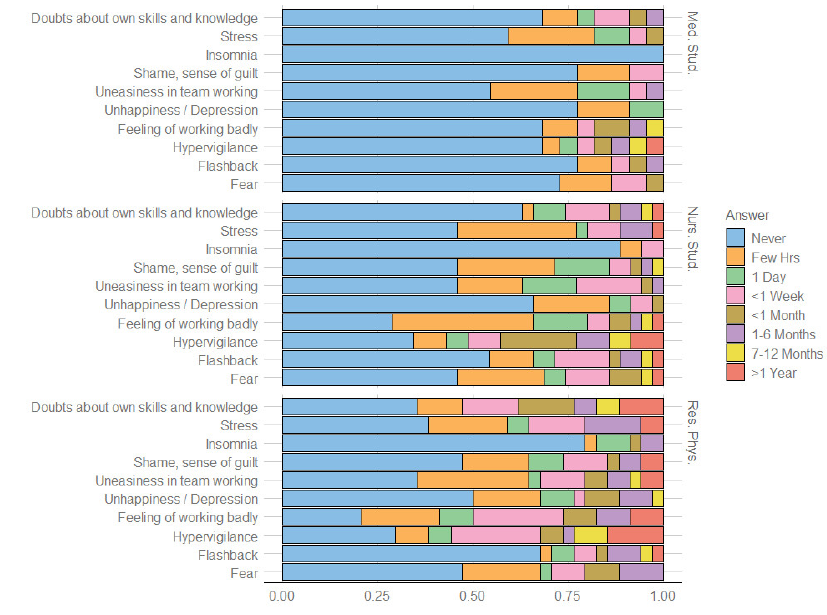
Figure 2. Responders’ duration of symptoms after the